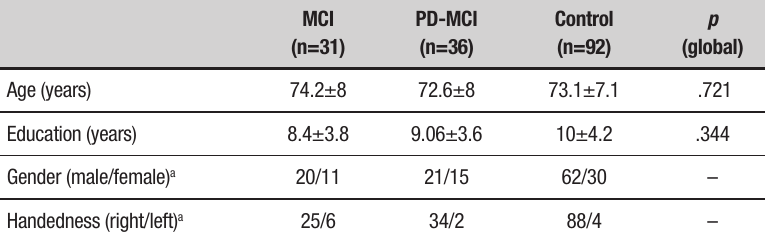
Table 1. Demographics of PD-MCI patients, MCI subjects and controls.